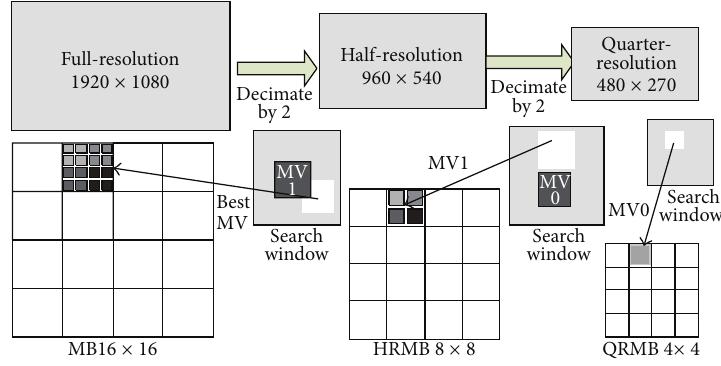
Figure 4: Concentration of the original frame into lower resolution